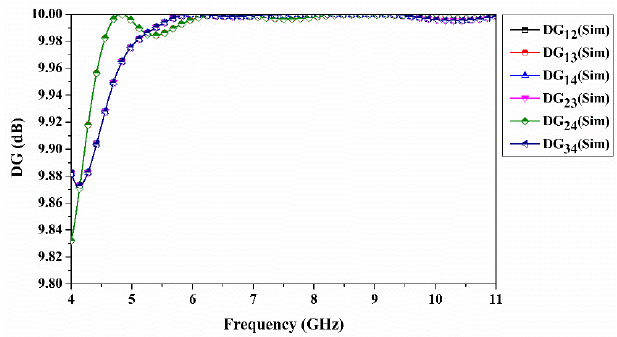
Figure 11. Simulated diversity gain of quad-port antenna.